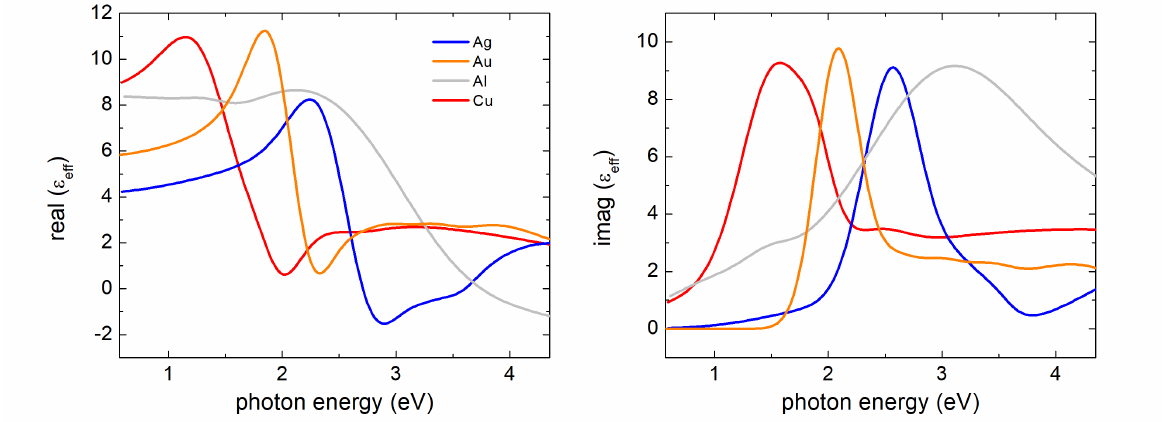
Figure 10. Real (left) and imaginary (right) of the effective dielectric function of fabricated metal island films of 5 nm mass thickness made of Ag, Au, Al and Cu as determined from ellipsometry